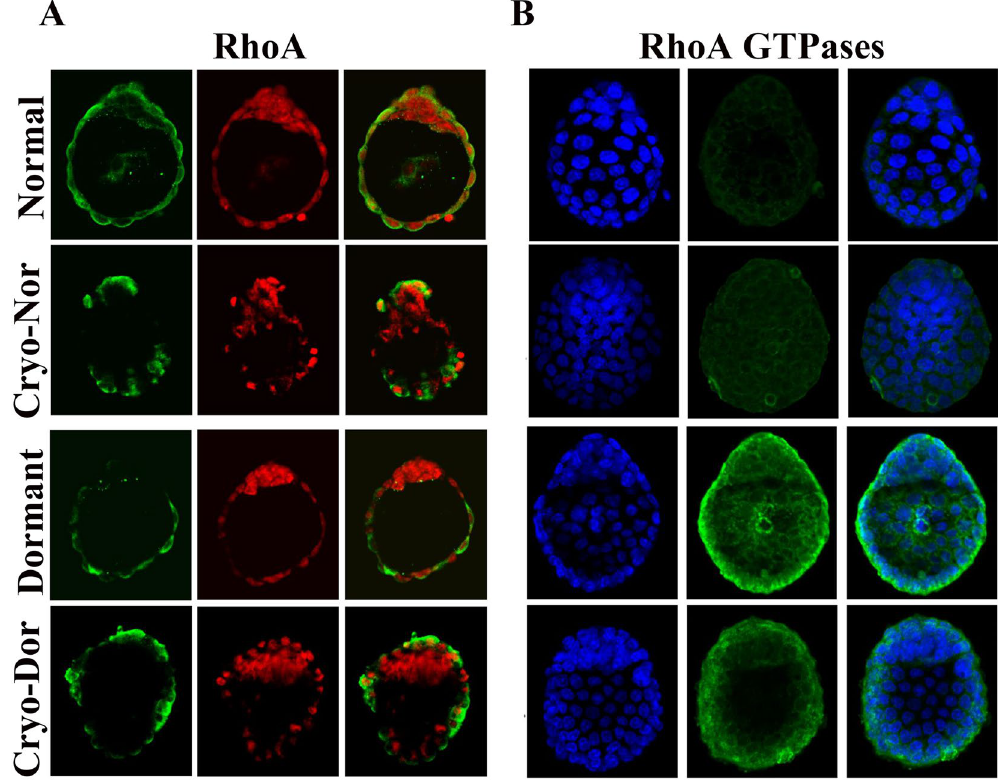
Figure 2. Localisation of total RhoA and phospho-RhoA in mouse embryos (10 × 20 magnification). ( A ) Images show RhoA antigen labelled in green, propidium iodide labeled nuclei in red, and the merged images. ( B ) images showing phospho-RhoA antigen labelled in green, Hoechst 33342 labelled nuclei in blue, and the merged images.